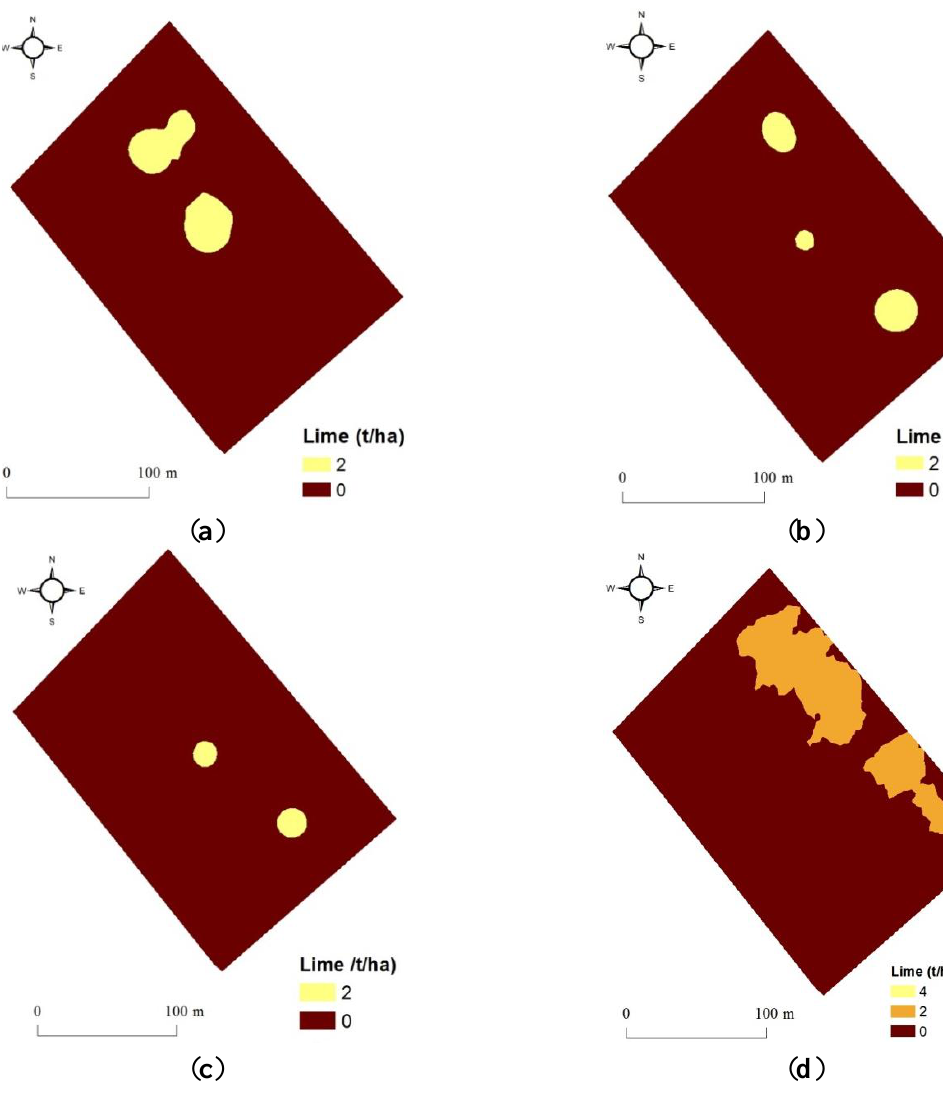
Figure 6. Lime application maps based on pH values obtained from ( a ) laboratory reference measured, ( b ) off-line visible and near infrared (vis-NIR) predicted and ( c ) on-line vis-NIR predicted, based on 16 validation points. ( d ) Lime recommendation map based on full-point on-line vis-NIR predicted pH values (2,160